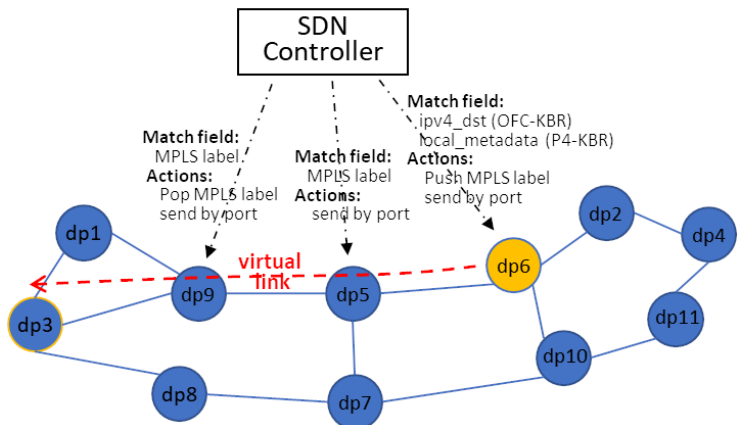
Figure 4. Physical path implementation of a virtual link using MPLS